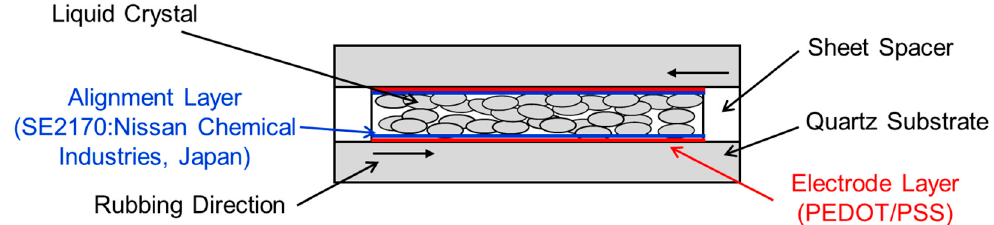
Figure 2. Structure of electrically tunable phase shifter for a terahertz wave.